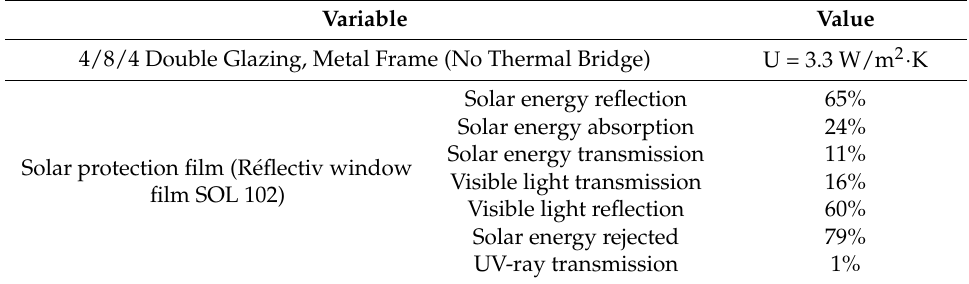
Table 2. Thermal and solar characteristics of the window. Source: Data sheet from manufacturer. Variable